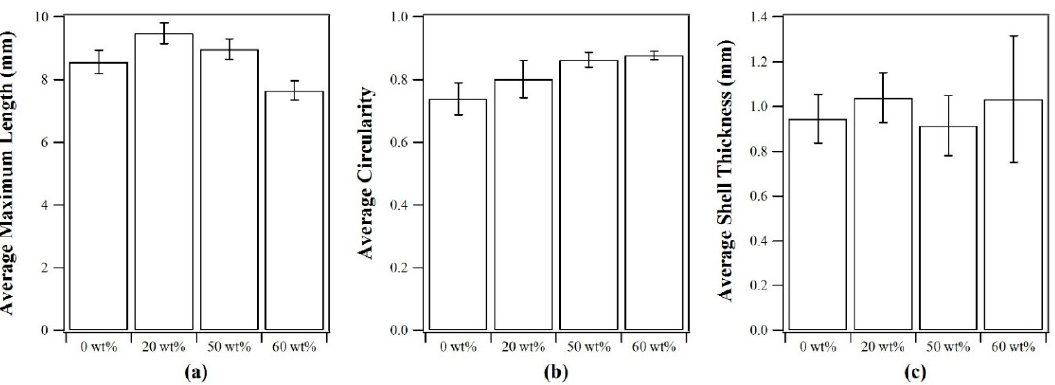
Figure 3. ( a ) Average maximum capsule length, ( b ) average capsule circularity, and ( c ) average shell thickness for capsules prepared from emulsions with different initial silicone oil compositions. Error bars represent standard deviation, n = 9.